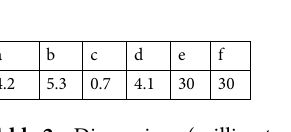
Table 2. Dimensions (millimeters).